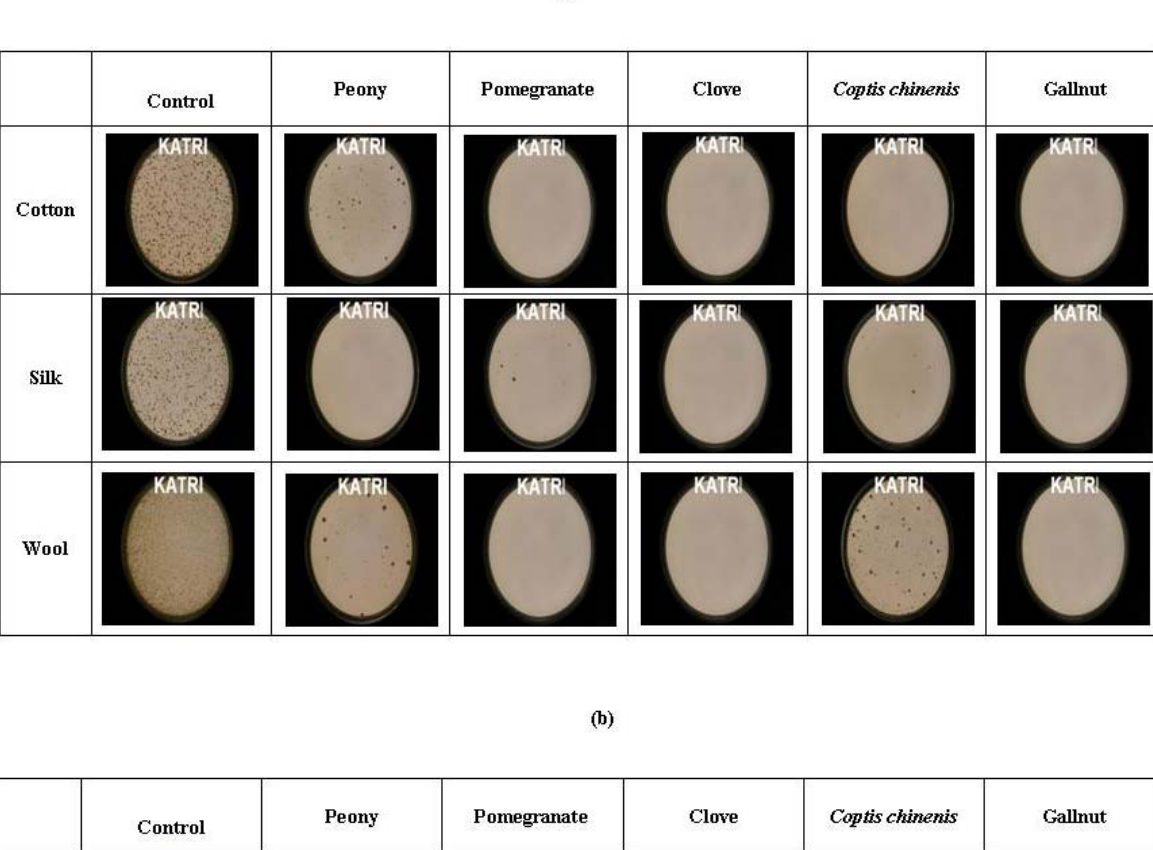
Figure 4. The micrographs of antibacterial activity of control fabrics and dyed fabrics using various natural colorants against (a) Staphylococcus aureus and (b) Klebsiella